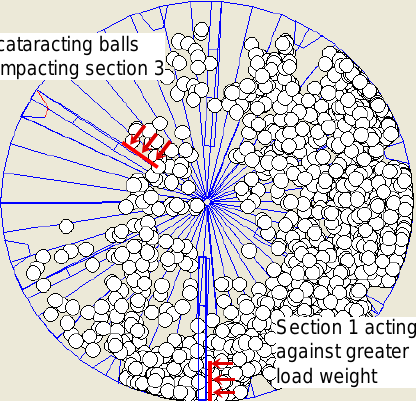
Figure 6. Illustration of how the forces act on the different sections of the end lifters.